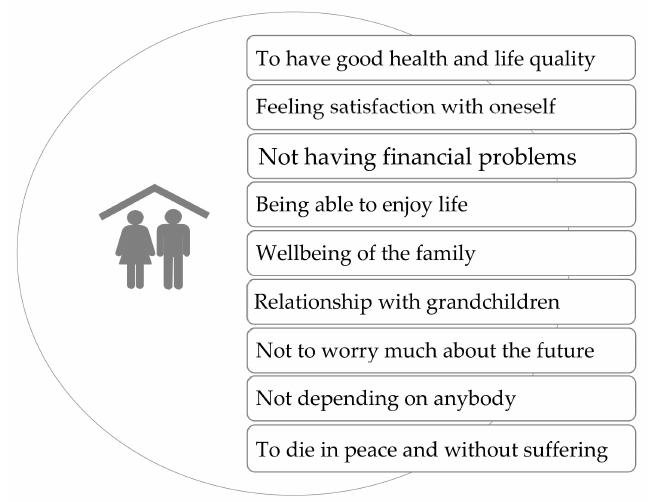
Figure 3. Main priorities in older people’s